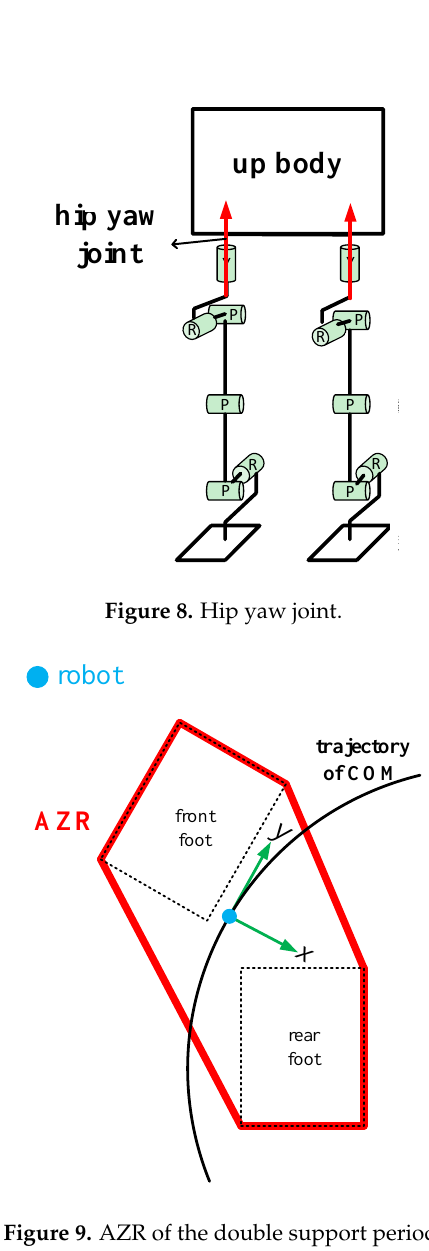
Figure 9. AZR of the double support